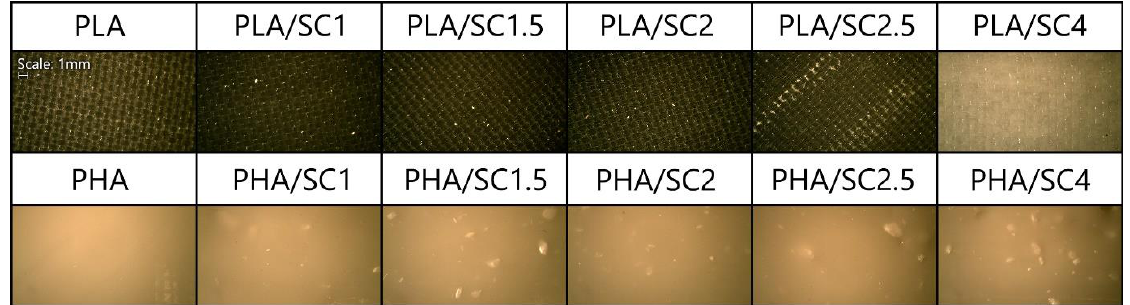
Figure 4. Visualization of PLA and PHA samples with succinic acid. Photographs taken with an optical microscope at 50× magnification.